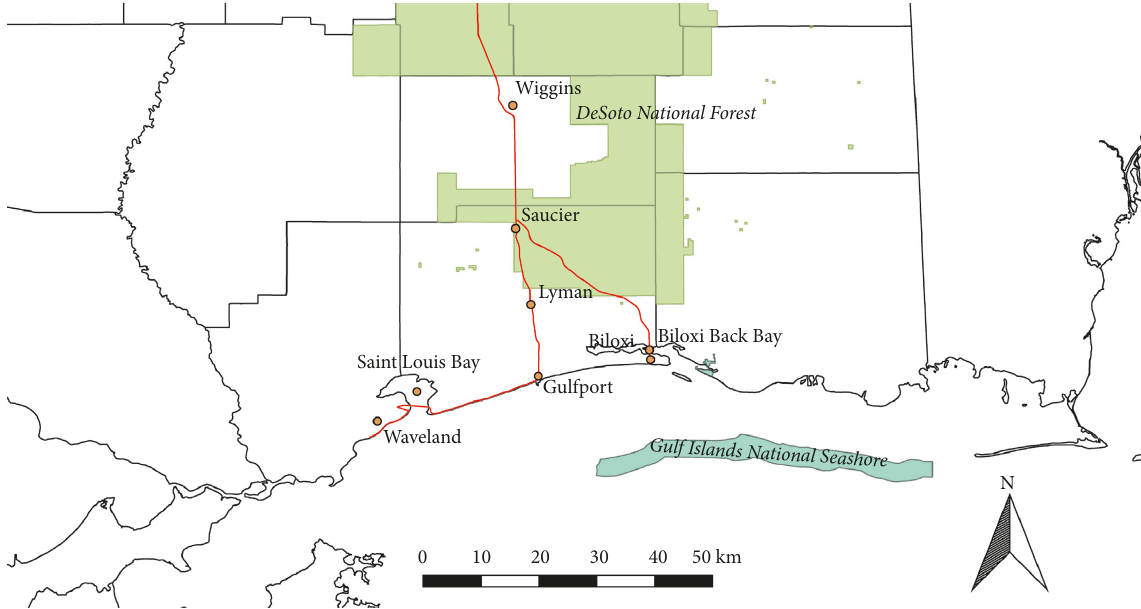
Figure 2: Routes and locations referred to in the text.